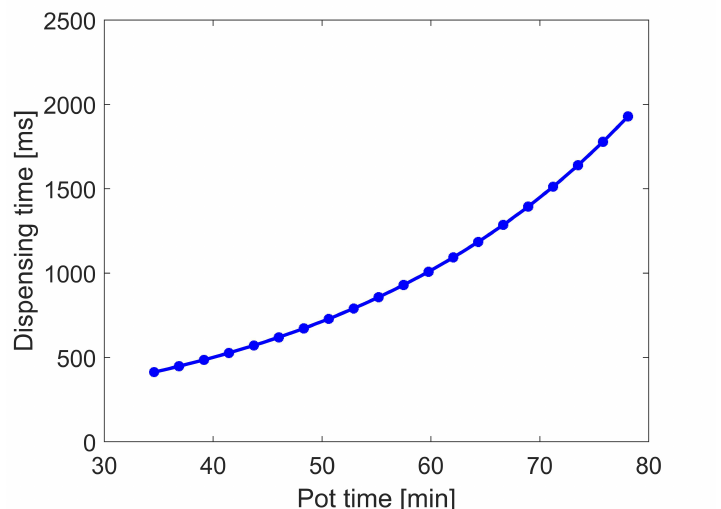
Figure 6. Adapted dispensing time for a single adhesive dot.